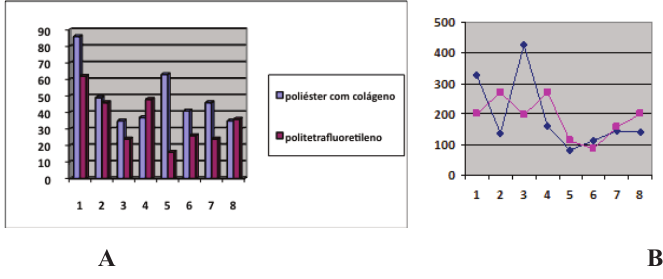
FIGURE 5 - Graphs of tensile strength ( A ) and maximum deformity ( B ) - 90 days.